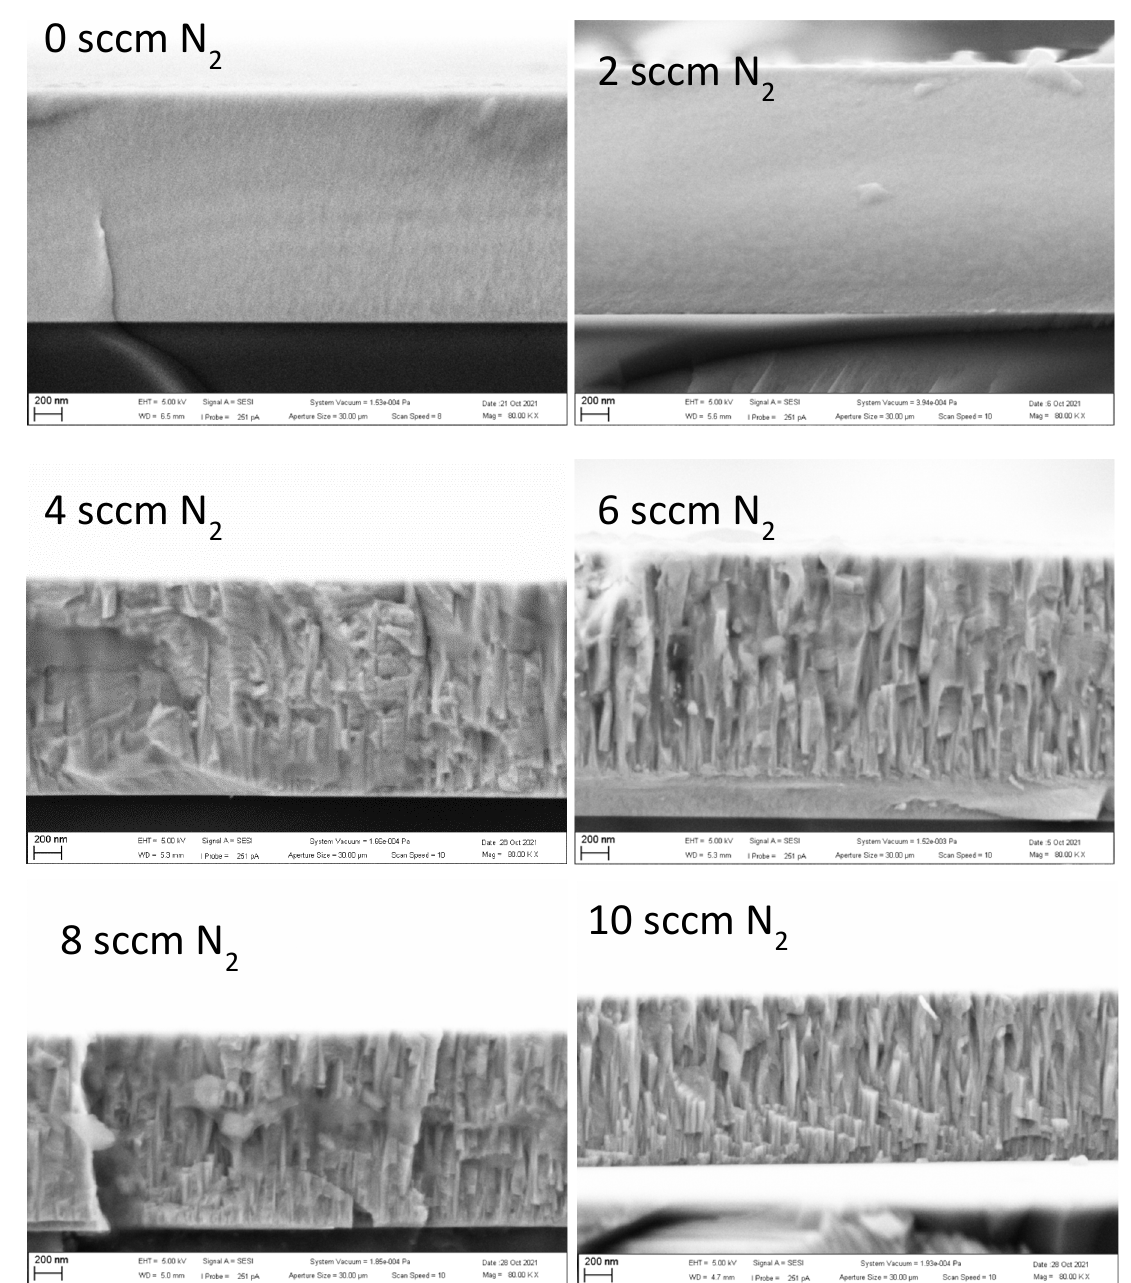
Figure 3. Fractured cross-sections of HiTUS TiNbVTaZrHf-xN coatings deposited with different flows of N 2 in Ar sputtering atmosphere.